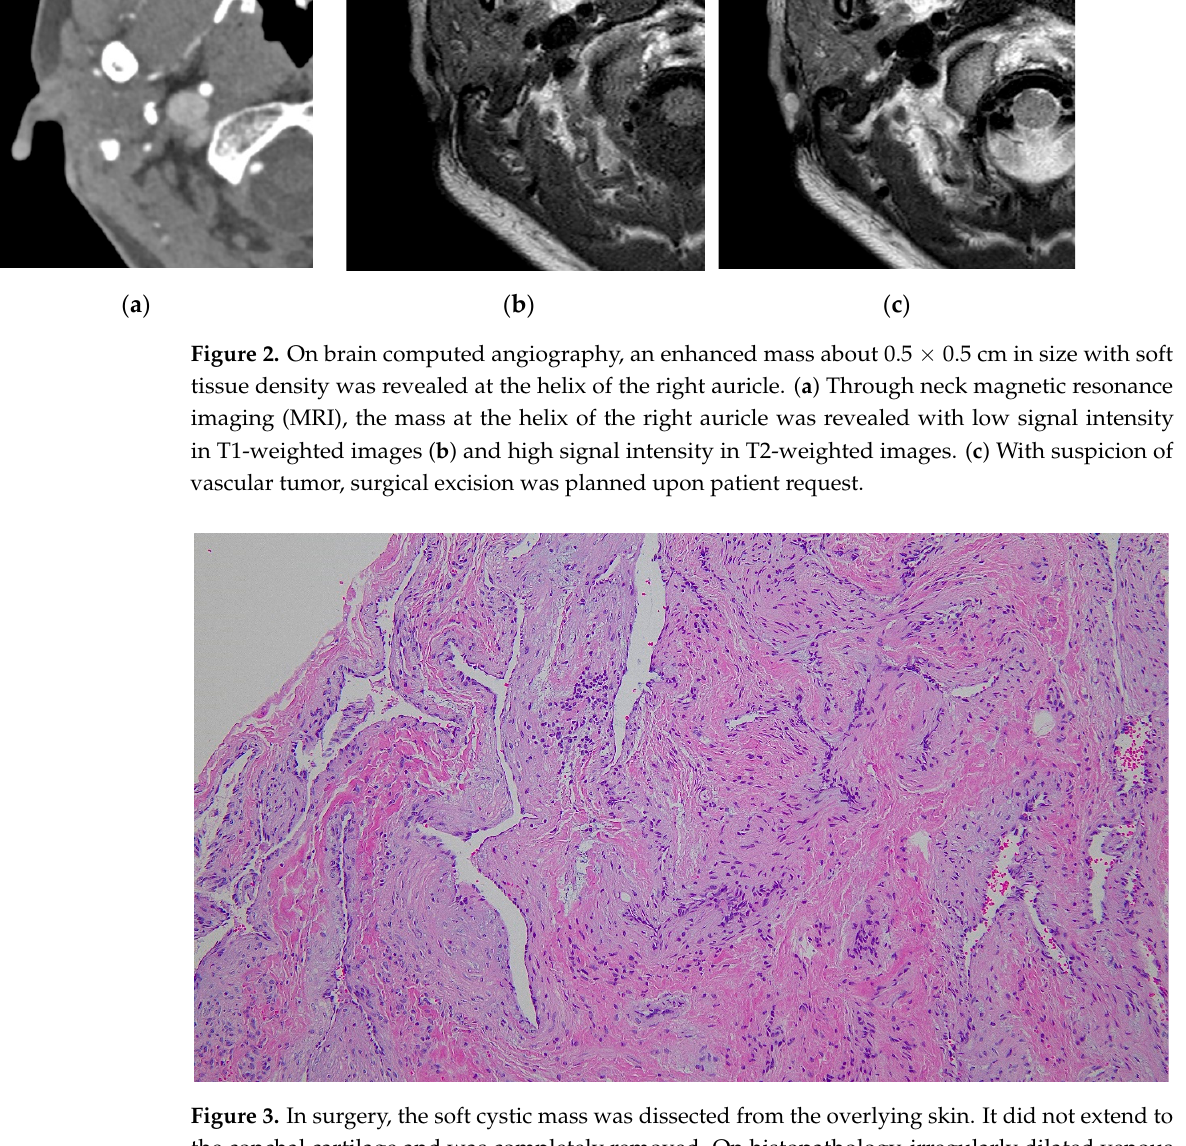
Figure 3. In surgery, the soft cystic mass was dissected from the overlying skin. It did not extend to the conchal cartilage and was completely removed. On histopathology, irregularly dilated venous channels with sparse smooth muscle cells without arteries were observed (hematoxylin-eosin, ×100). Thus, venous malformation was diagnosed. Six months after surgery, the wound had healed well and there was no recurrence.